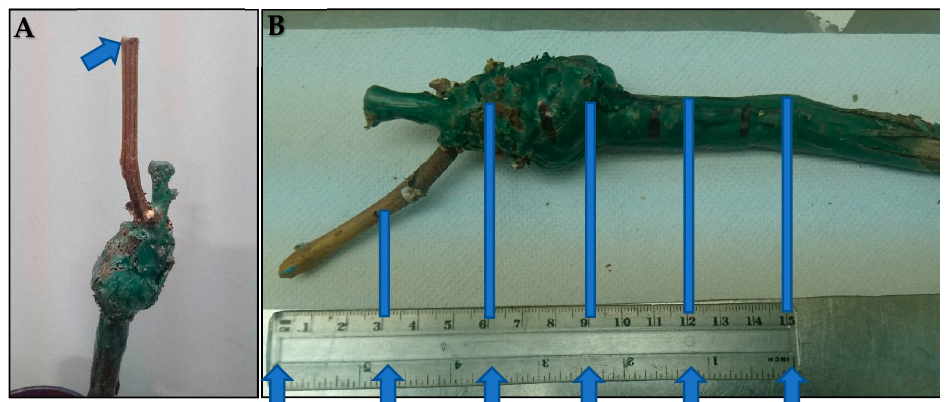
Figure 5. ( A ) Inoculation point. ( B ) Points of evaluation after inoculation. The evaluation of the pruning wounds to study the capacity of Trichoderma to colo- nize the pruning wounds was performed by re-isolating the fungal strains from the inoc- ulation points 12 weeks after the inoculation at a concentration of 2 × 10 − 6 CFU/mL from both the T154 and T071 strains.